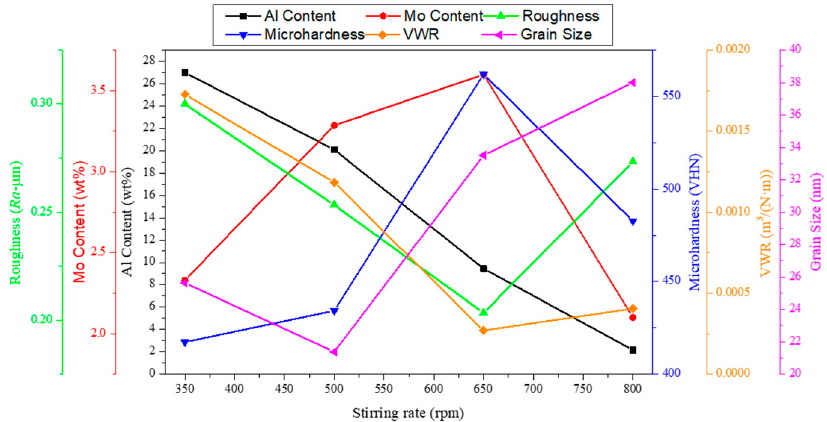
Figure 9. The effect of stirring rate on the grain size, chemical composition, volumetric wear rate (VWR), roughness, and microhardness properties of coatings obtained at current density of 30 mA/cm 2 , temperature of 40 °C, Al content in the solution of 5 g/L, and different stirring rates.